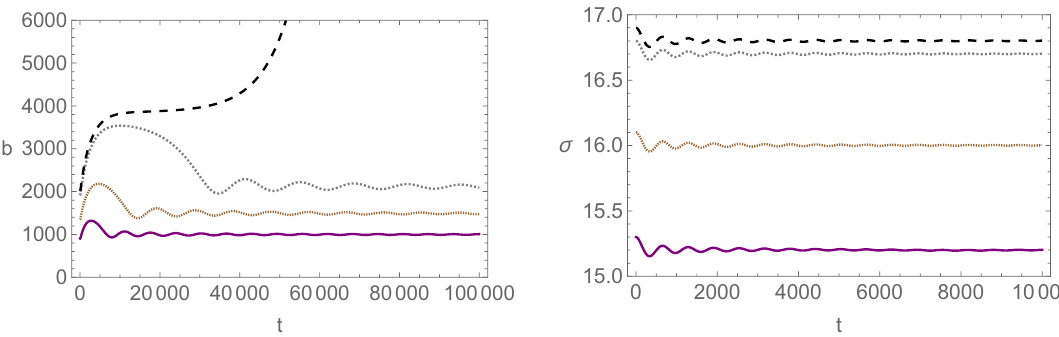
Figure 11. Time evolutions of b (left plot) and σ (right plot). The parameter σ ∗ is chosen from the bottom to the top as σ = 15 . 2 (purple), 16.0 (brown fine dashed), 16.7 (gray fine dashed), 16.8 ∗ (black coarse dashed), which correspond to b = 1000 , 1490 , 2115 , 2223 , respectively. The other vac parameters are chosen as